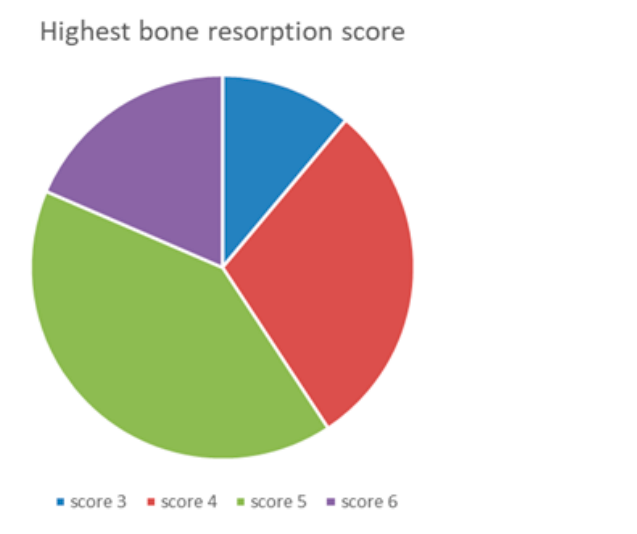
Figure 7. Highest bone resorption scores registered per patient according to Cawood and Howell [23].